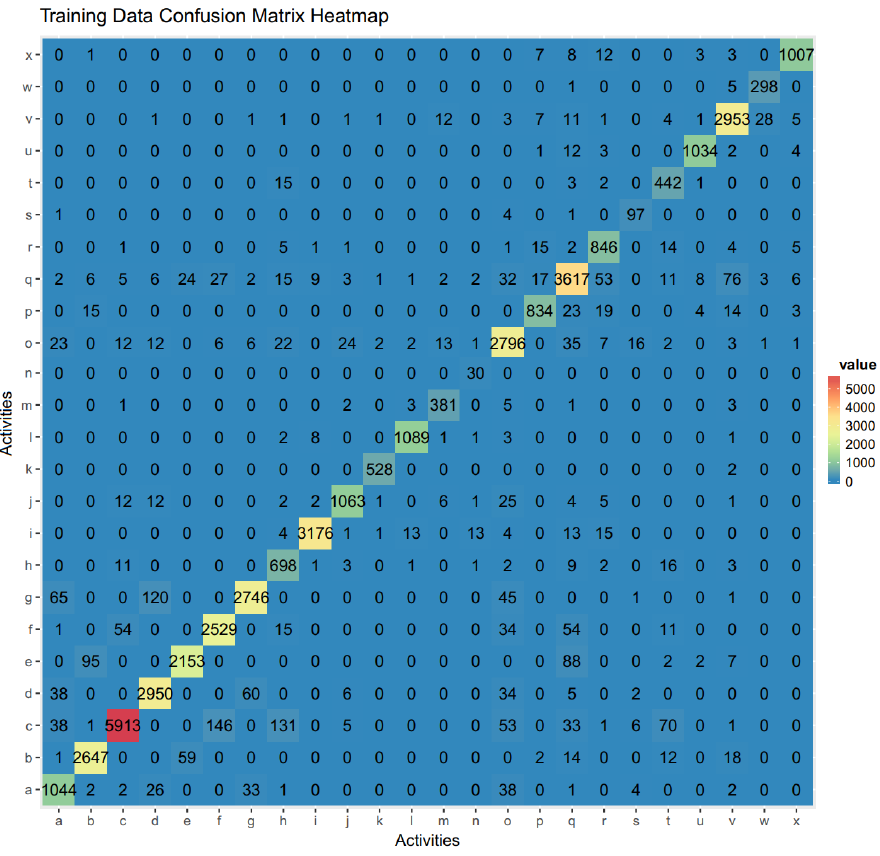
Figure 3. a = Act01, b = Act02, c = Act03, d = Act04, e = Act05, f = Act06, g = Act07, h = Act08, i = Act09, j = Act10, k = Act11, l = Act12, m = Act13, n = Act14, o = Act15, p = Act16, q = Act17, r = Act18, s = Act19, t = Act20, u = Act21, v = Act22, w = Act23, x =